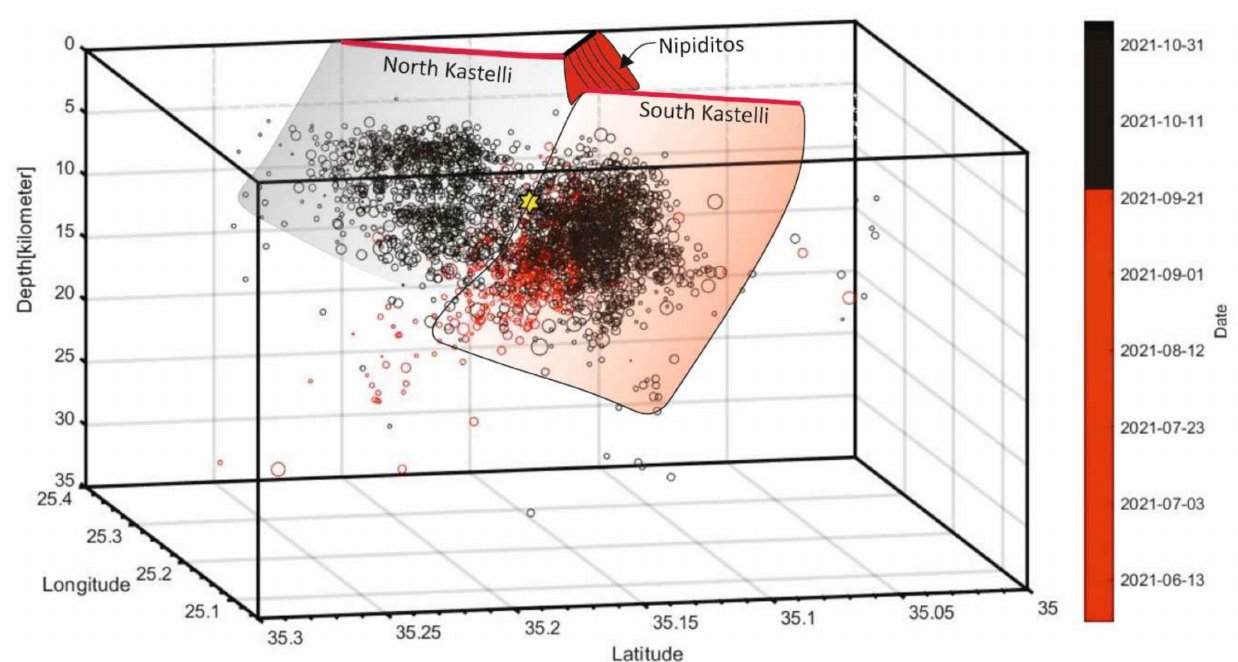
Figure 12. 3-D seismotectonic model seen from NW for the interpretation of the seismotectonics associated with the 27 September 2021 Arkalochori main shock (star) and its dependent foreshocks (red circles) and aftershocks occurring up to 5 November 2021 (black circles). The Nipiditos Fault, which is younger than the Kastelli Fault (KF), truncates KF nearly perpendicularly (see also Figure 4). Only the northern KF segment is exposed at surface. The main shock very likely ruptured the inferred southern KF segment since all the foreshocks and aftershocks of M L ≥ 4.0 and a large part of the geodetic deformation area all fall in that segment (see also text in Section 4 and Figure 4). The aftershock activity expanded gradually to the northern KF